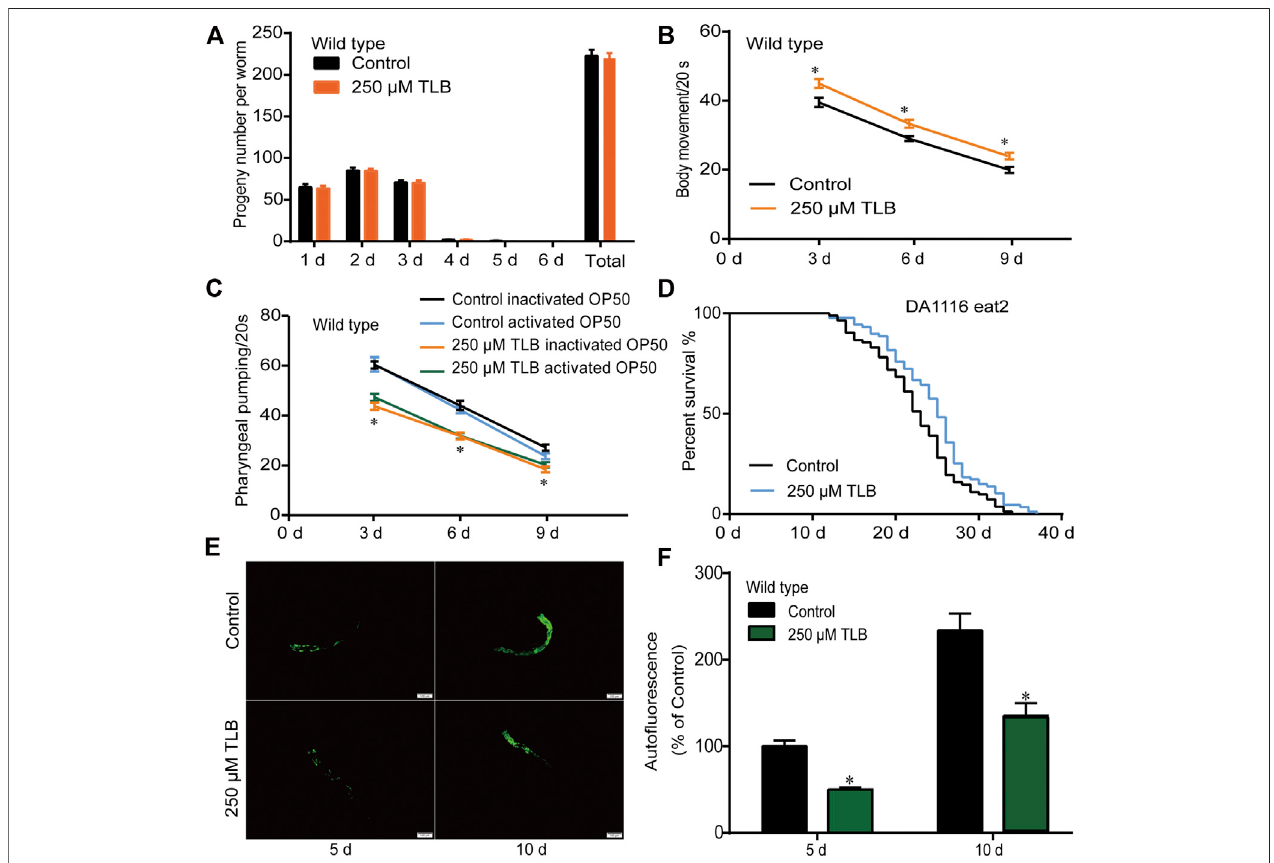
FIGURE 2 | TLB changed behaviors in aging C. elegans . (A) The number of progeny per day and the total number of progeny of C. eleganss treated with 250 μ M TLBattheonsetofage-synchronizedlateL4oryounglarvae C.elegans ( n (cid:2) 10). (B) Age-synchronizedlateL4larvaeoryoung C.elegans werebredonNGMagarplates withorwithout250 μ MTLBat20 ° Cfor3,6,and9 days, C.elegans bodymovementwerecountedwithtimesofsinusoidalmotionduring20 s( n (cid:2) 20). (C) Theeffectsof TLB on food intake in C. elegans were determined the times of the pharynx contraction for 20 sat 20 ° C for 3, 6, and 9 days ( n (cid:2) 10). p values were calculated by independent-samples t test. (D) The survival curves of eat2 (DA1116) C. elegans raised on 0 and 250 μ M TLB at 20 ° C ( n (cid:2) 82 – 87). The lifespan was analyzed by the Kaplan-Meier test, and p values were calculated by the log-rank test. (E) Representive lipofuscin auto fl uorescence image of 0 and 250 μ M TLB C. elegans on the 5 and 10 days of adulthood. The fl uorescence of C. elegans were observed under a fl uorescence microscopy. (F) The mean pixel fl uorescence of transgenic C. elegans were quanti fi ed using the Image Pro Plus 6.0 software. Magni fi cation × 100; scale bar, 100 μ m ( n (cid:2) 20). Data were presented as mean ± SEM. * p < 0.05 vs. non-TLB treated